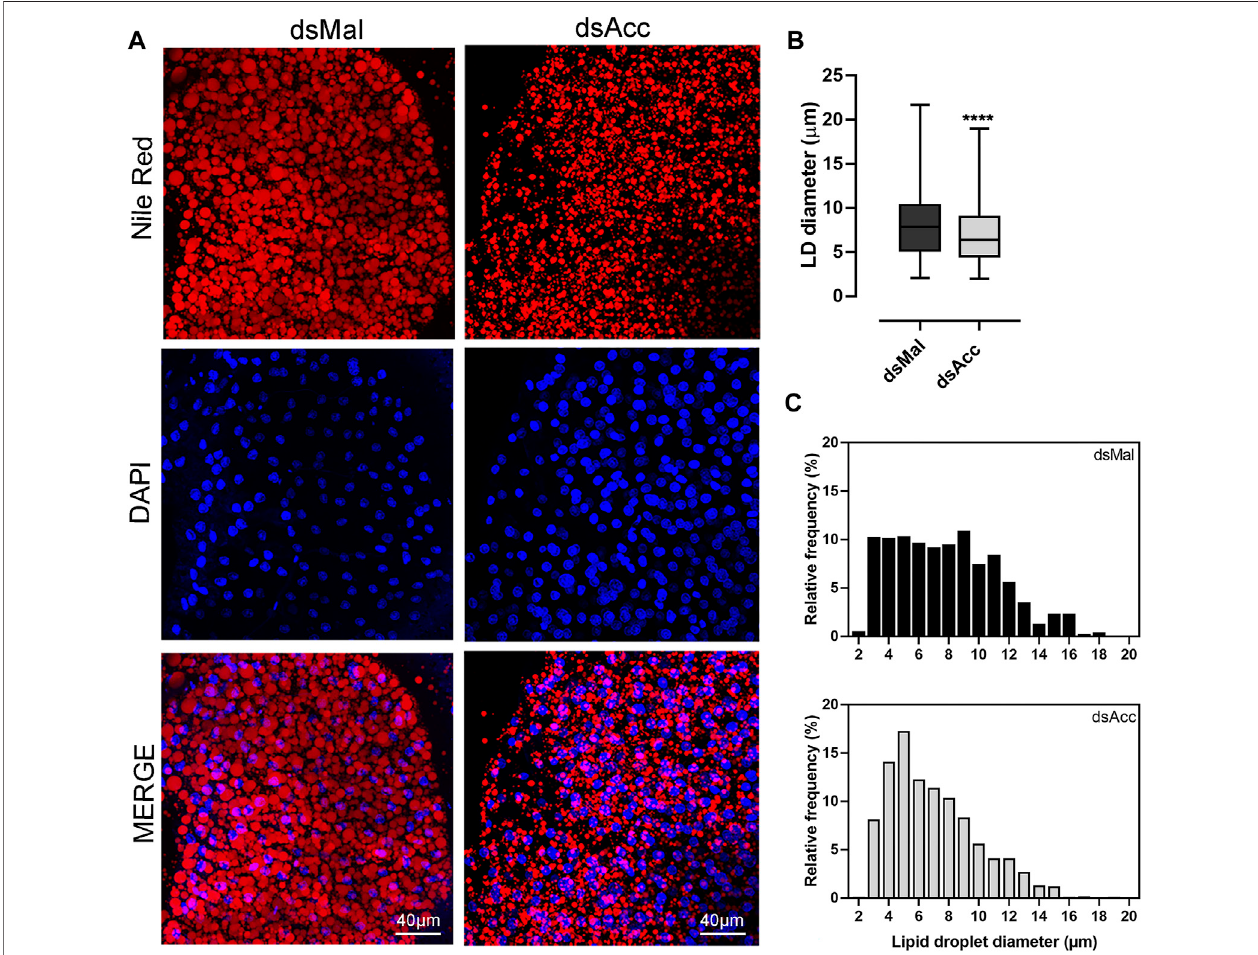
FIGURE 4 | Smaller lipid droplets in the fat body of Acc knockdown females. Starving adult females were injected with 1 µg of dsRNA for Acc or Mal (control) and werefed3 dayslater. (A) Atthe fi fthdayafterbloodmeal,freshlydissectedfatbodieswerestainedwithNileRedandDAPIandobservedunderalaserscanningconfocal microscope. Bars: 40 μ m. (B) Maximum diameters of lipid droplets (LDs) were determined from four to fi ve images obtained from at least four insects, in three experiments, and theresultsaremeans ±SDforatleast 1037LDsper group. (****): p < 0.0001byStudent ’ s t -test. (C) Diameterdistribution histogramsoftheLDs from panel